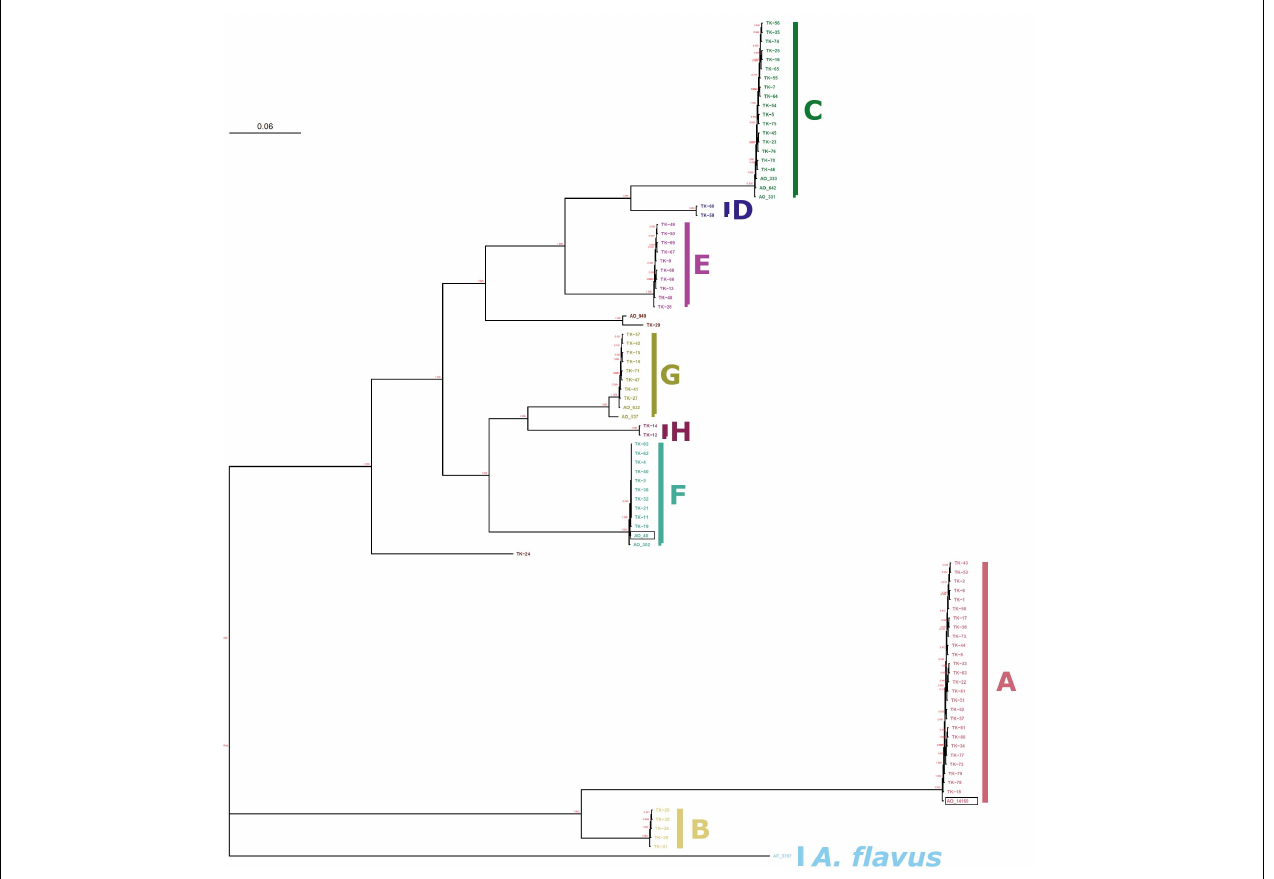
FIGURE 1 | Phylogenetic relationship of A. oryzae 14160 and RIB 40. Maximum-likelihood phylogeny of 91 A. oryzae isolates and A. flavus NRRL 3357. Clades are labeled with respect to the nomenclature used by Watarai et al. (2019). A. oryzae 14160 and A. oryzae RIB 40 are outlined with a black back and belong to clades F and A,